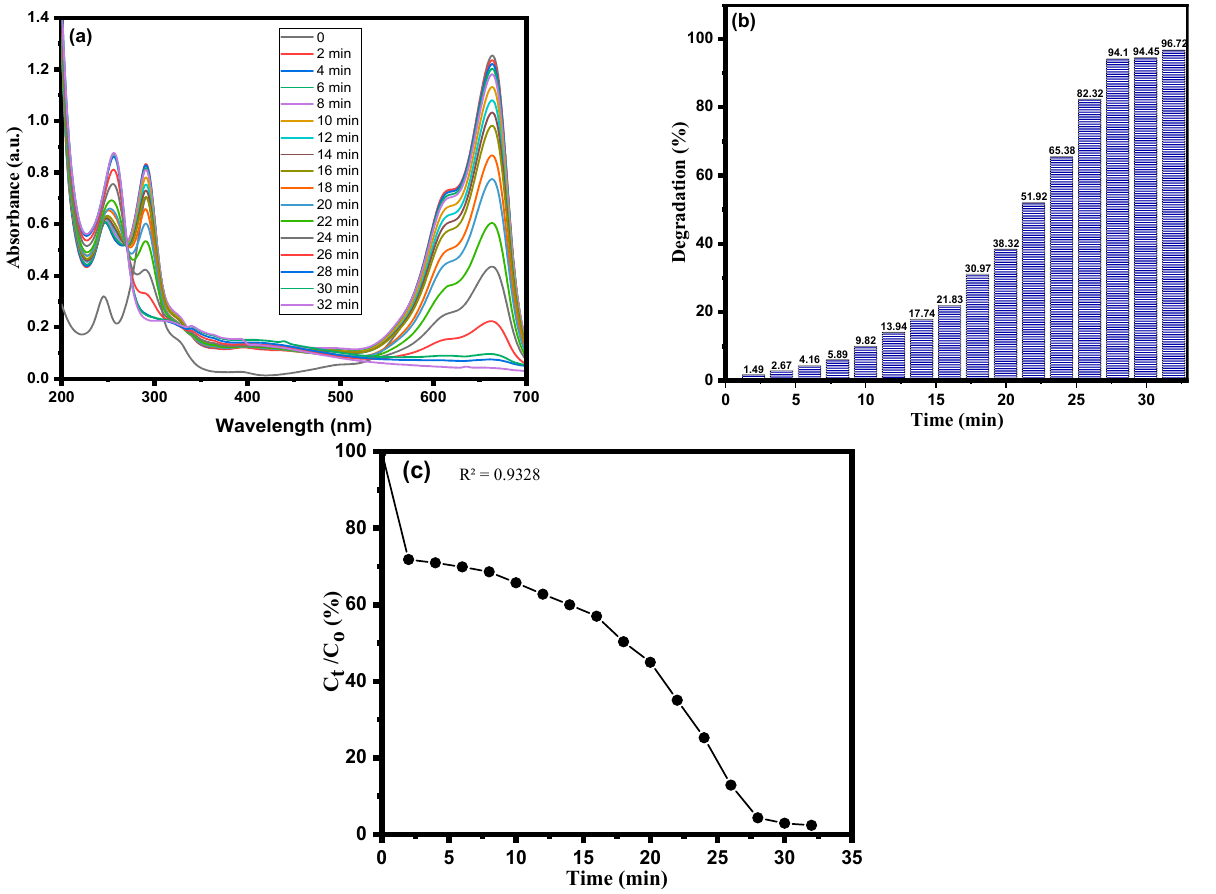
Figure 9. Results of MB dye degradation studies with CA-AgNPs ( a ) UV–Visible spectra, ( b ) Degradation %; ( c ) C t /C o (%) vis time graph.